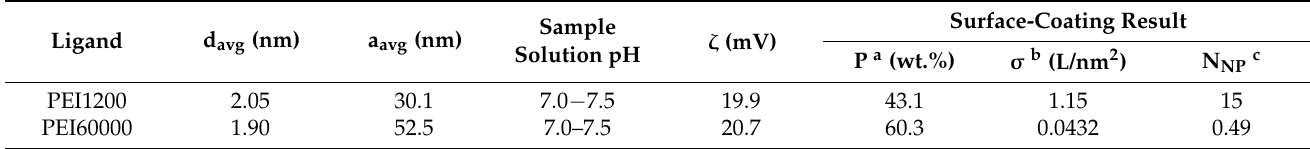
Figure 2. HRTEM images of ( a ) PEI1200- and ( b ) PEI60000-coated ultrasmall Ho 2 O 3 nanoparticles. Dotted circles indicate individual nanoparticles. Large dotted circles in ( b ) indicate nanoparticles grafted together with one PEI60000. ( c ) Particle diameter distributions and log-normal function fits of PEI1200- and PEI60000-coated ultrasmall Ho 2 O 3 nanoparticles. EDS spectra of ( d ) PEI1200- and ( e ) PEI60000-coated ultrasmall Ho 2 O 3 nanoparticles. Table 1. Summary of the observed physicochemical properties of PEI1200- and PEI60000-coated ultrasmall Ho 2 O 3 nanoparticles.